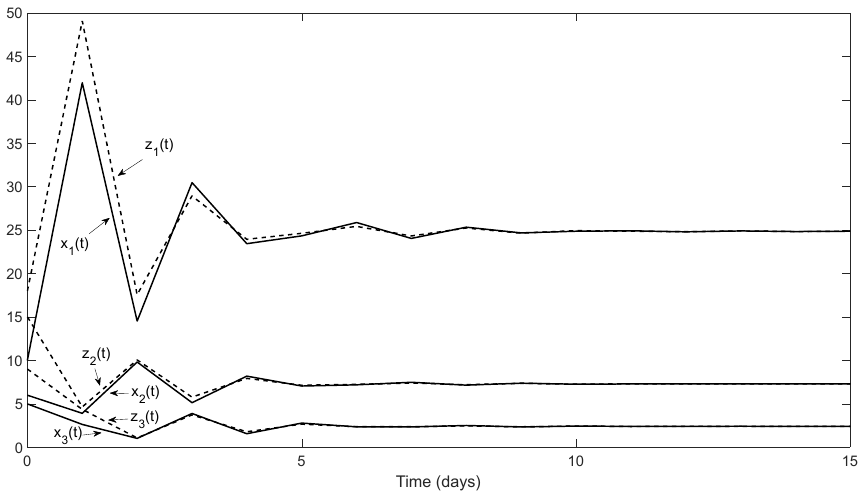
Figure 4. The solution of the observer system approached the unknown solution of the original sys- tem.